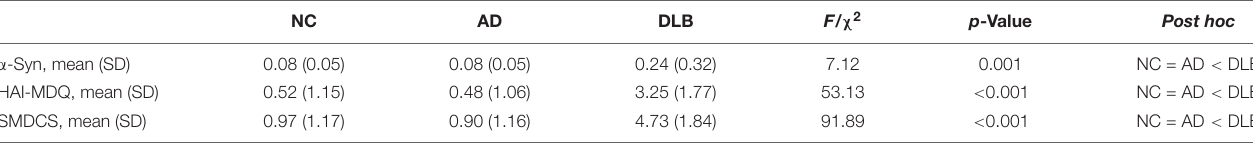
TABLE 2 | Comparison of plasma α -synuclein, HAI-MDQ, and SMDCS among NC ( n = 31), AD ( n = 31), and DLB ( n = 59) patients. NC AD DLB F / χ 2 p -Value Post